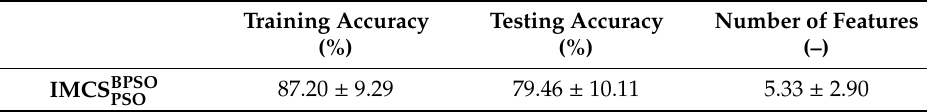
Table 2. Classification performance of the algorithm over 20 independent runs using a reference MD space based on defective samples.